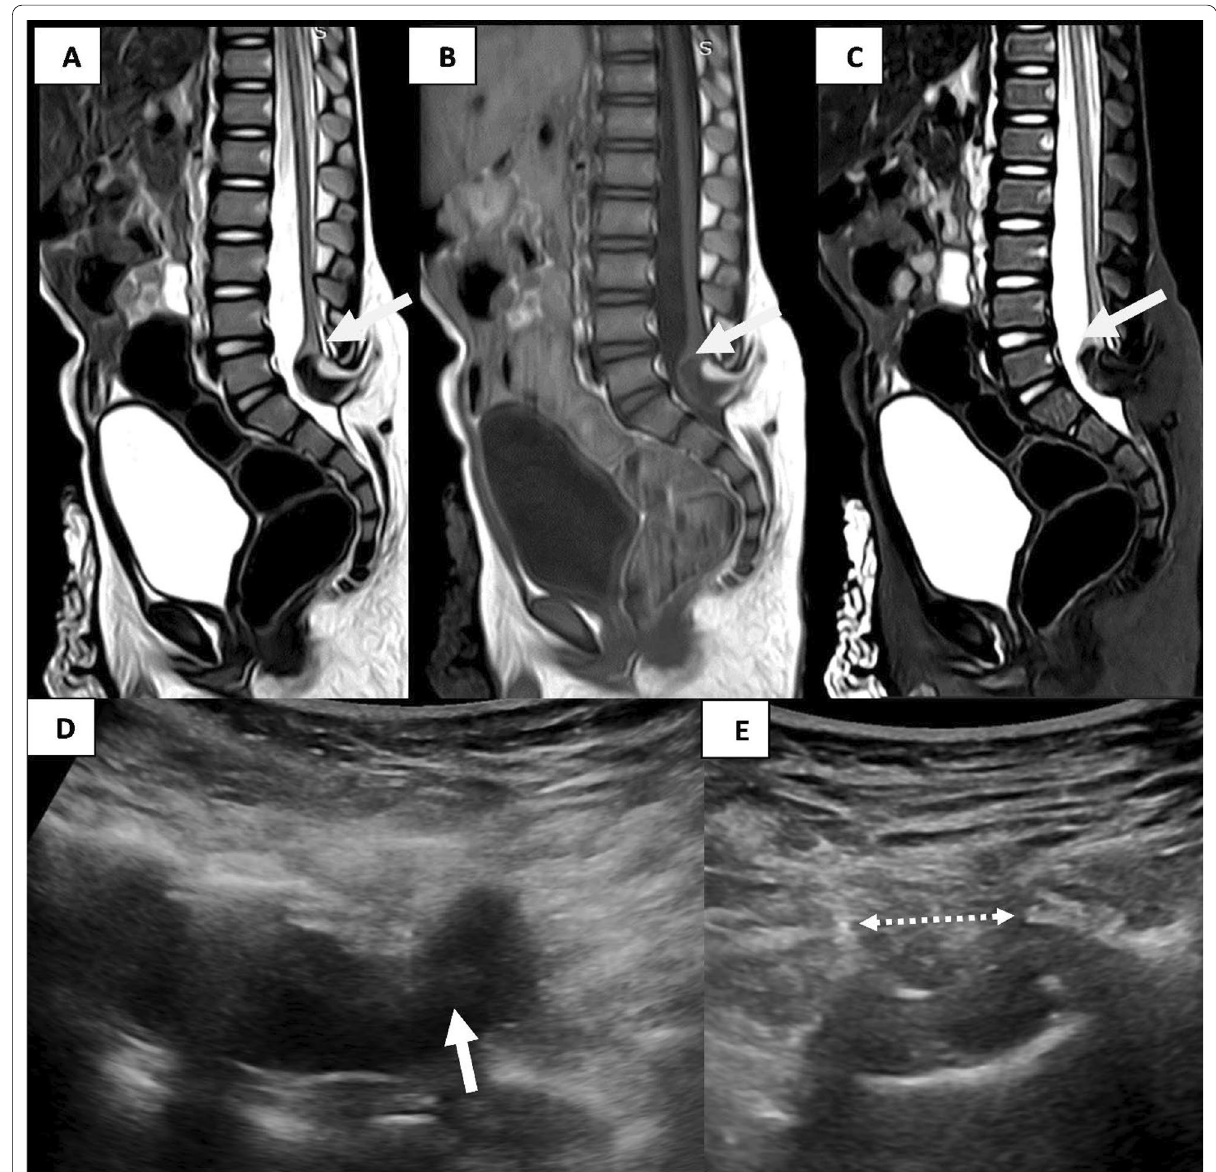
showing tethered cord ending at level of L5 with a subcutaneous fatty mass extending into spinal canal through non fused spinous process of L5, S1 and S2 as well as dural defect with lipoma placode interface seen within spinal canal (white arrows in A , B and C ), a hypointense lesion is seen at the interface likely fibrous/calcified elements. D Sagittal USG image showing tethered cord at level of L5 (white arrow). E Axial USG image at level of L5 showing non fused spinous process with herniation of subcutaneous fat into spinal canal. Type of spinal dysraphism: